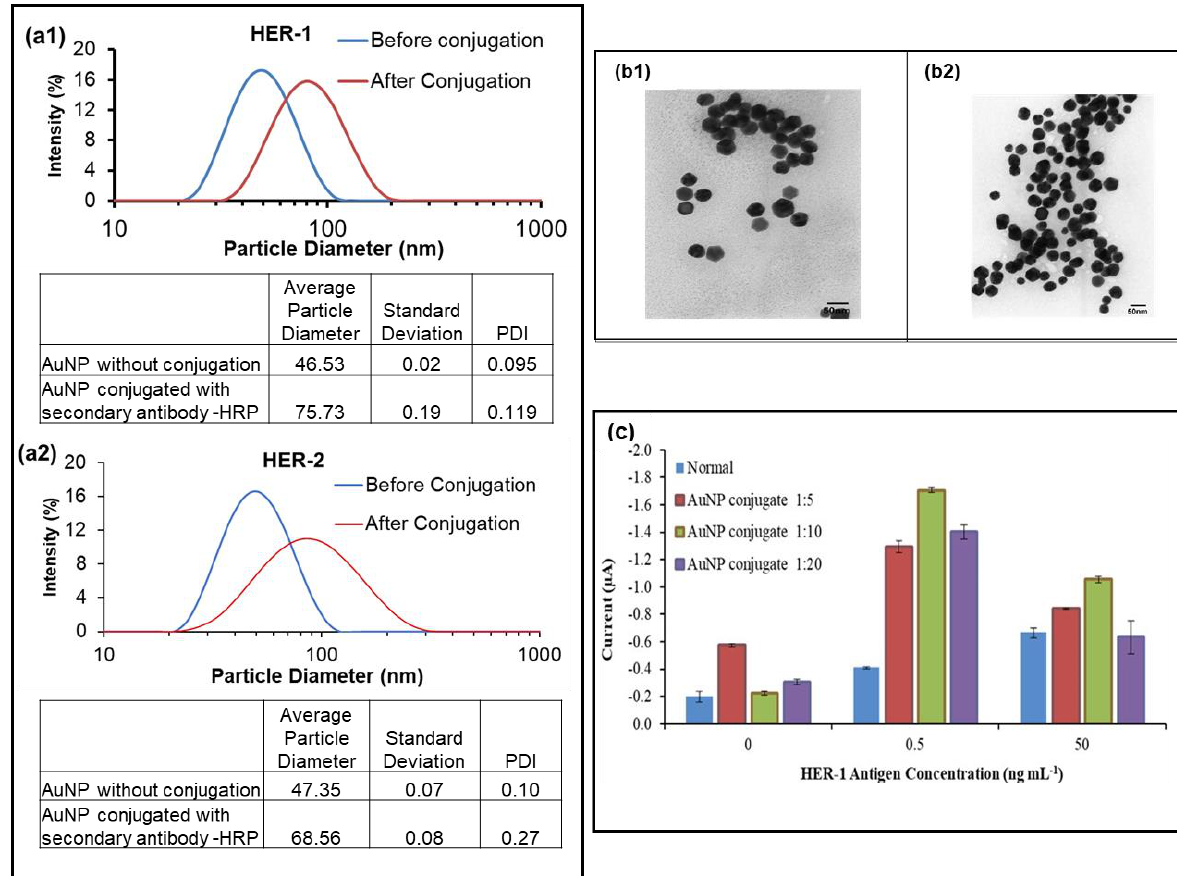
Figure 3. The DLS results of the AuNP, before and after conjugation; ( a1 ), HER-1; ( a2 ), HER-2. Standard deviations were calculated for experiments performed in triplicate. ( b1 ), TEM imaging results of the gold nanoparticle before conjugation; ( b2 ), after conjugation with anti-rabbit -HRP; ( c ) HER-1, used here as an example of data achieved using different AuNP conjugate dilution ( n = 3). 3.5. Standard Plot for the Optimized AuNP-Ab-HRP Conjugate Immunosensor